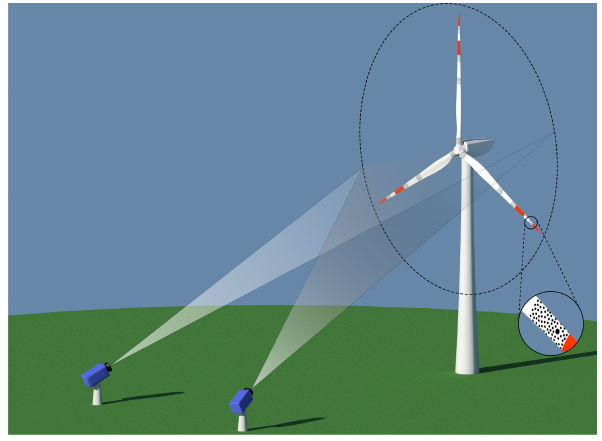
Figure 1. Schematic of a camera set-up in front of a full-scale wind turbine. The magnified cut-out near the blade tip shows the random black-and-white pattern on the pressure side (Winstroth and Seume,